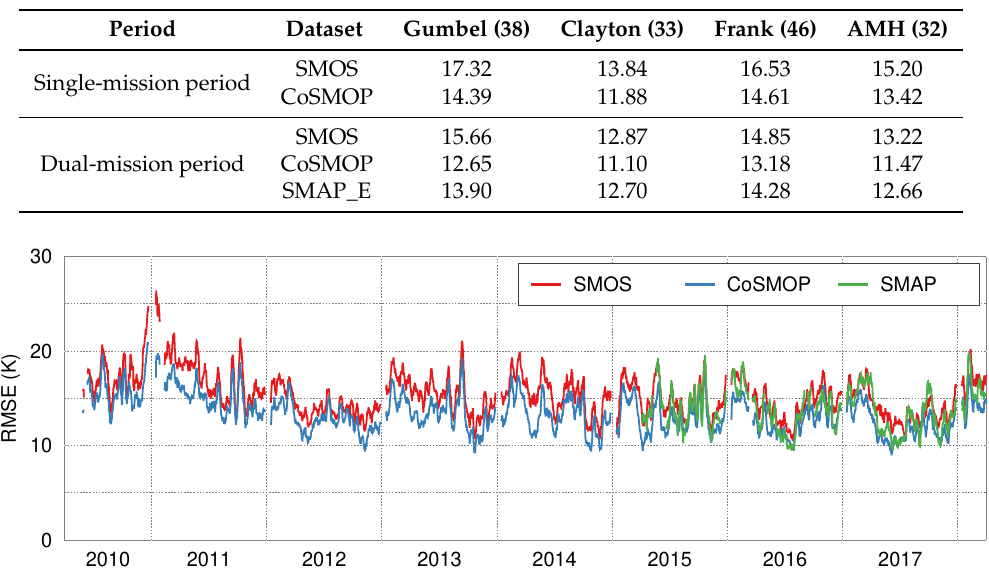
Figure 8. Temporal evolution of the average root mean squared error over 53 selected